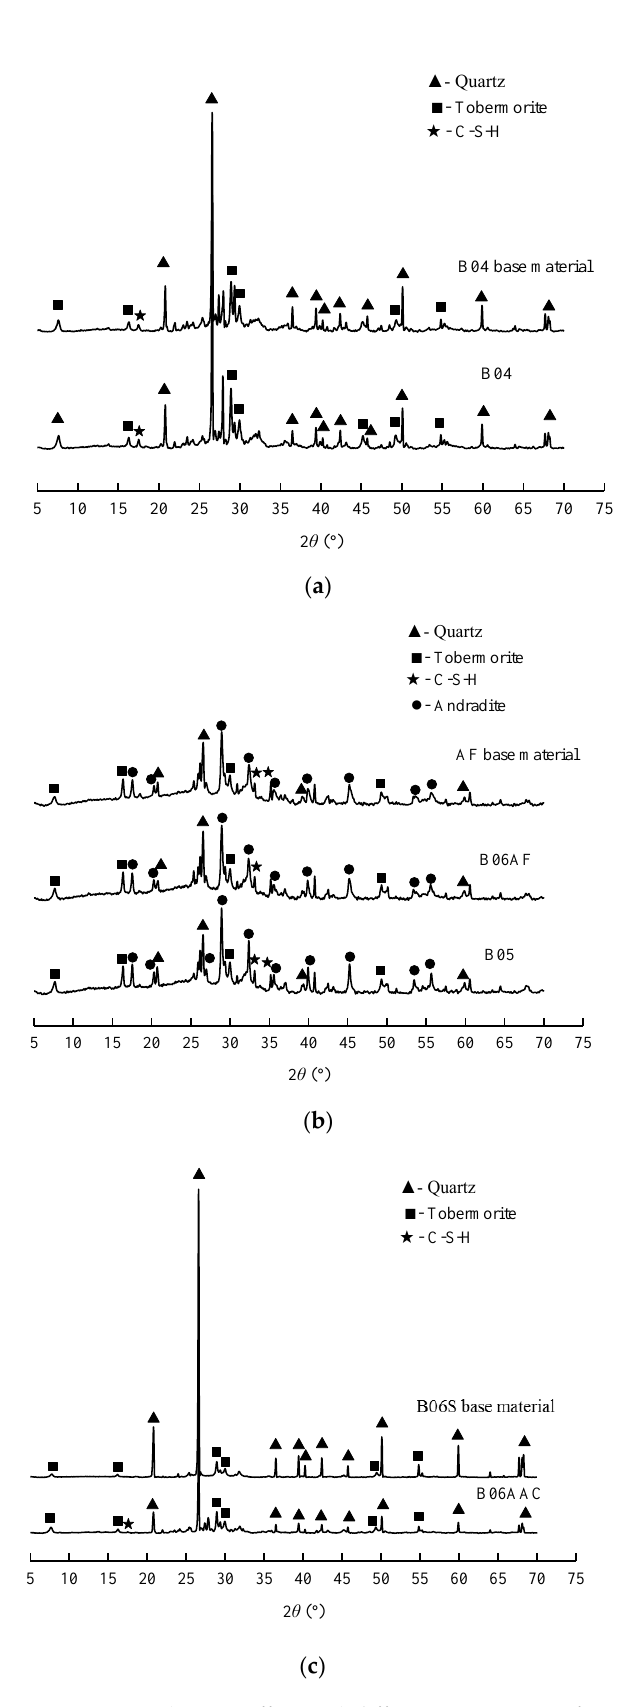
Figure 6. XRD (X-ray Diffraction) diffraction spectrum of AAC and base material: ( a ) B04 AAC and base material; ( b ) B05 and B06FA AAC and base material; ( c ) B06S AAC and base material.